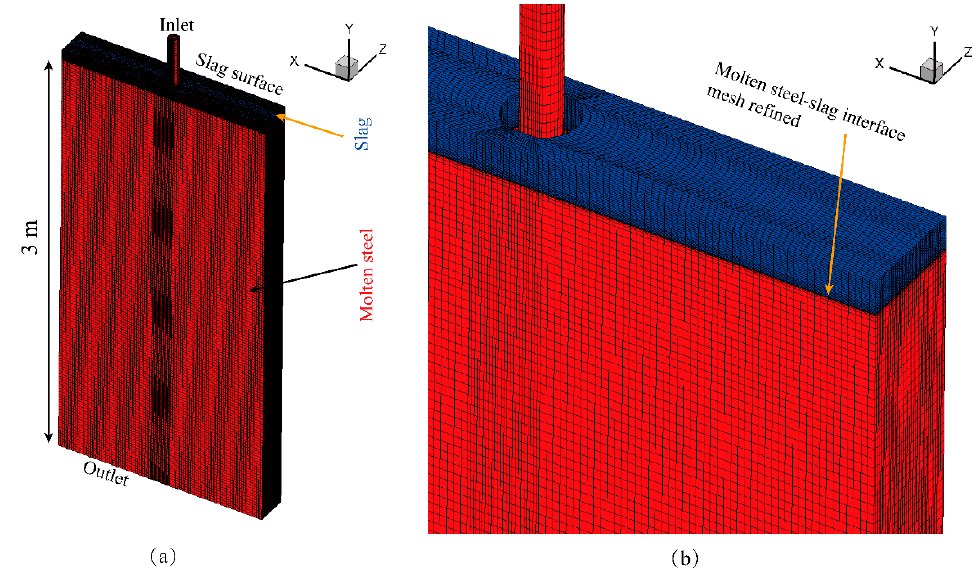
Figure 4. The grids of the part fluid flow domain. ( a ) the global view, ( b ) the partial enlarged view.